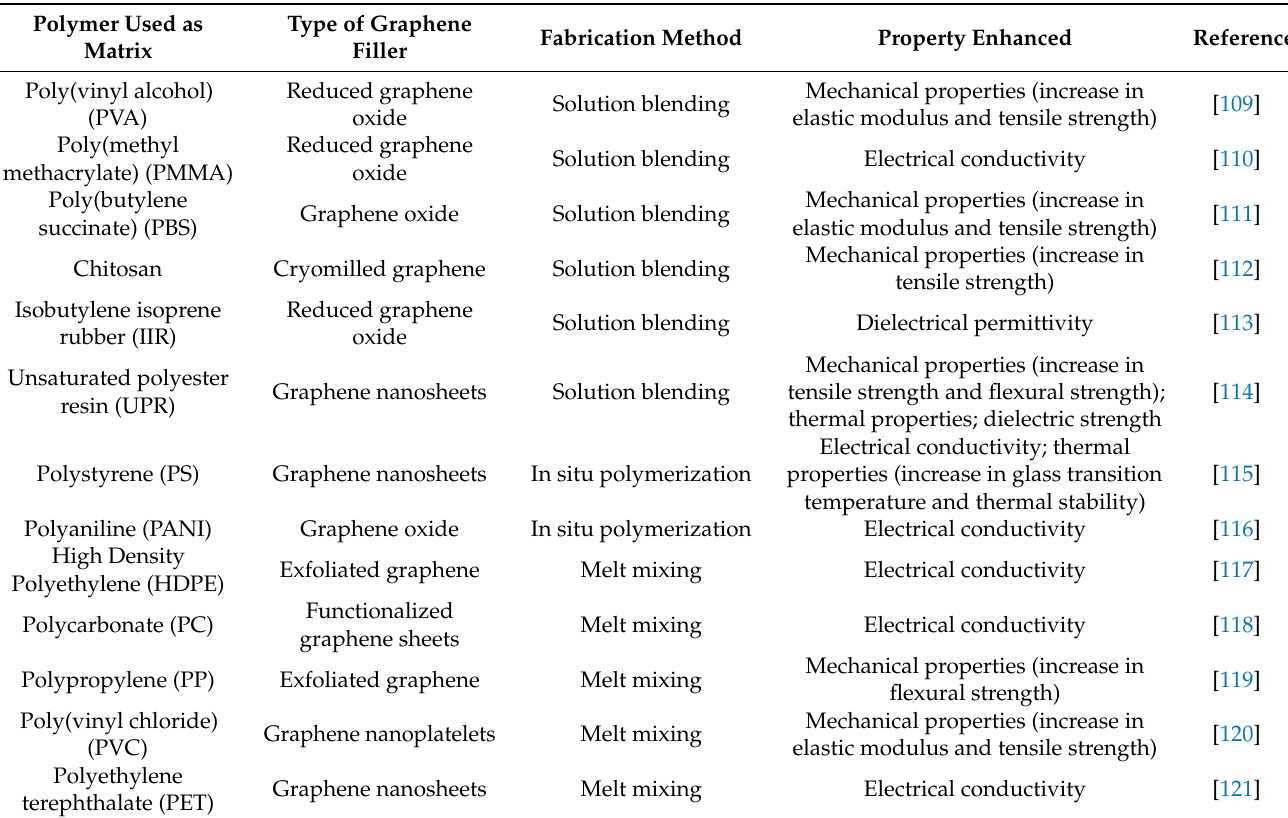
Table 3. Main polymers used in the fabrication of graphene-based nanocomposites, with the indica- tion of the fabrication method and the property enhancement induced by the